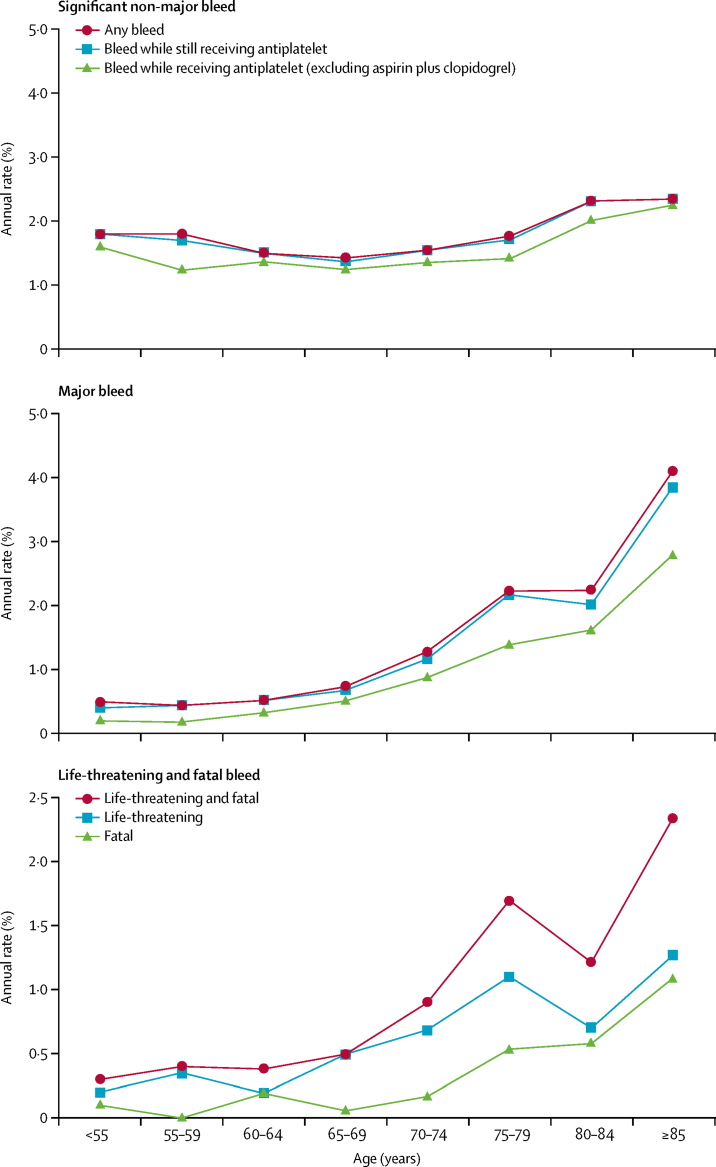
Age-specific annual rate of bleeding events requiring medical attentionStratified by severity and by antiplatelet treatment immediately before the event. Annual rate derived as number per 100 patient-years. We used Clopidogrel in Unstable angina to prevent Recurrent Events (CURE) criteria to define bleeding events as major (substantially disabling with persistent sequelae, intraocular bleeding leading to significant loss of vision, or bleeding requiring transfusion of ≥2 units of blood) and life-threatening or fatal (symptomatic intracranial haemorrhage, fall in haemoglobin of ≥5 g/dL, hypotension requiring intravenous inotropes, or required surgical intervention or transfusion of ≥4 units of blood).